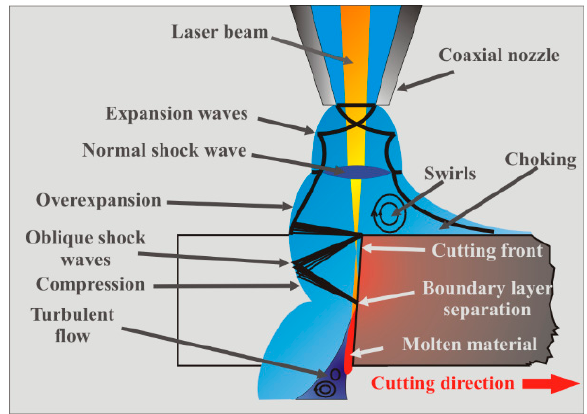
Figure 9. Aerodynamic interactions during laser cutting using a conical nozzle showing the boundary layer separation. Adapted with permission from [30]; Copyright 2010 Elsevier.